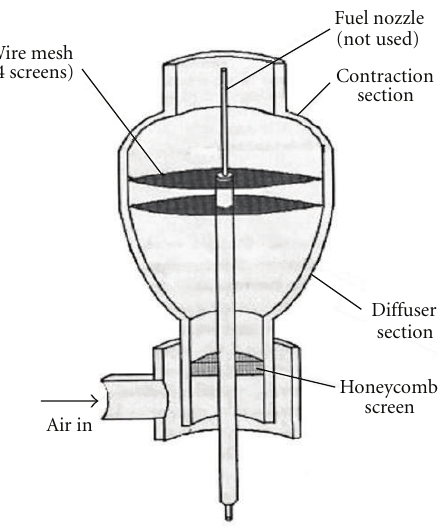
Figure 1: Burner apparatus for angled jet experiments.